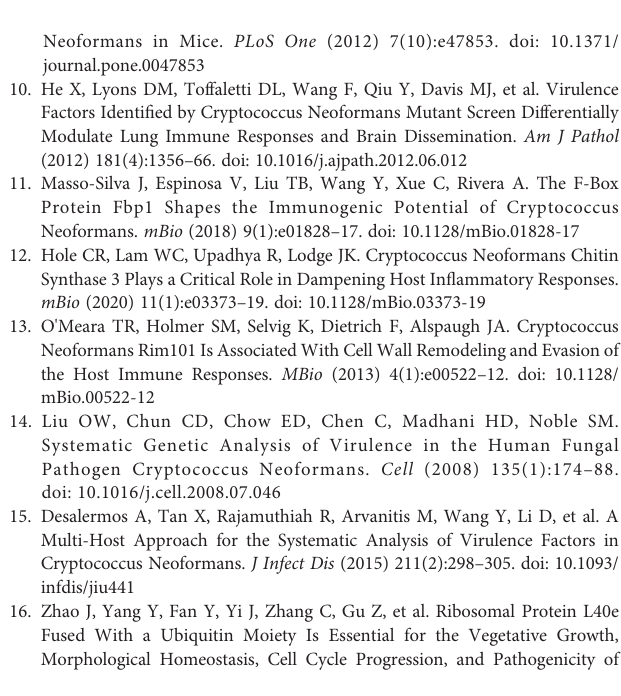
Supplementary Table 1 | Strains and plasmids used in this study. Supplementary Table 2 | Primers used in this